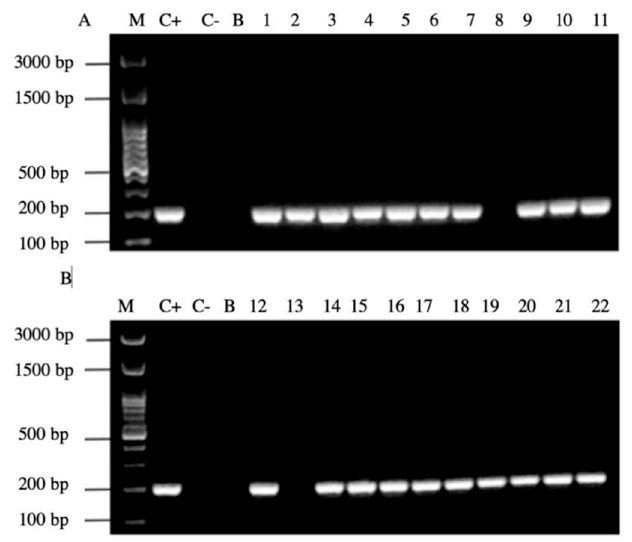
Figure 7. Agarose gel electrophoresis to detect the PCR amplification of the signal region s1a of vacA gene of H. pylori (expected size 190 pb) from the DNA of yeast cells from vaginal discharges of term pregnant women. Lane C+: DNA extracted from H. pylori ATCC 43504 strain (positive control). Lane C − : DNA extracted from C. albicans ATCC 90028 strain (negative control). Lane B: blank (PCR grade water) Lanes 1–11 ( A ) and 12–22 ( B ) DNA extracted from yeasts obtained from the vaginal discharge of term pregnant women. Alleles vacAs1b and vacAs2 were not detected by PCR In relation to the middle region of the gene vacA , 9/22 (40%) samples amplified for the region m1 All profiles obtained are shown in Table 5. Table 5. Frequency and percentage of genotypes of vaginal intrayeast H. pylori cells according to the amplification of the virulence genes cagA, vacA and dupA. Genotype